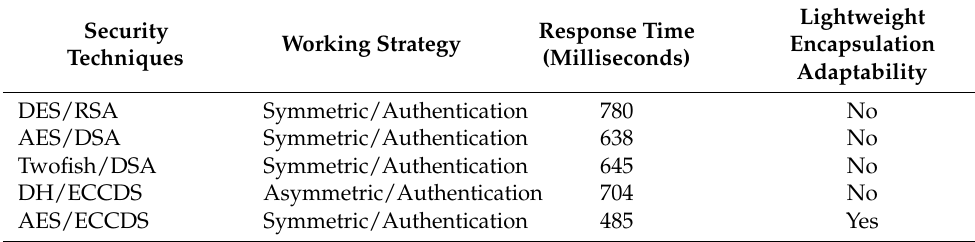
Table 3. Response Time and Security Strategy.